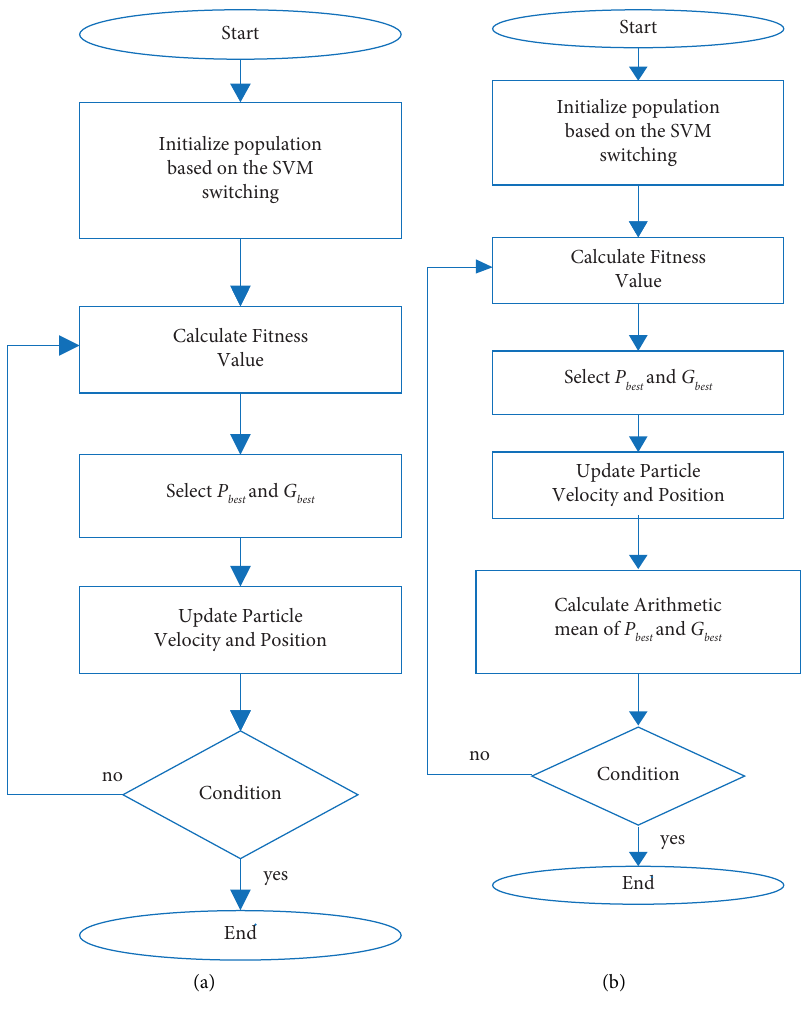
Figure 6: General fowchart of the (a) PSO and (b) MPSO